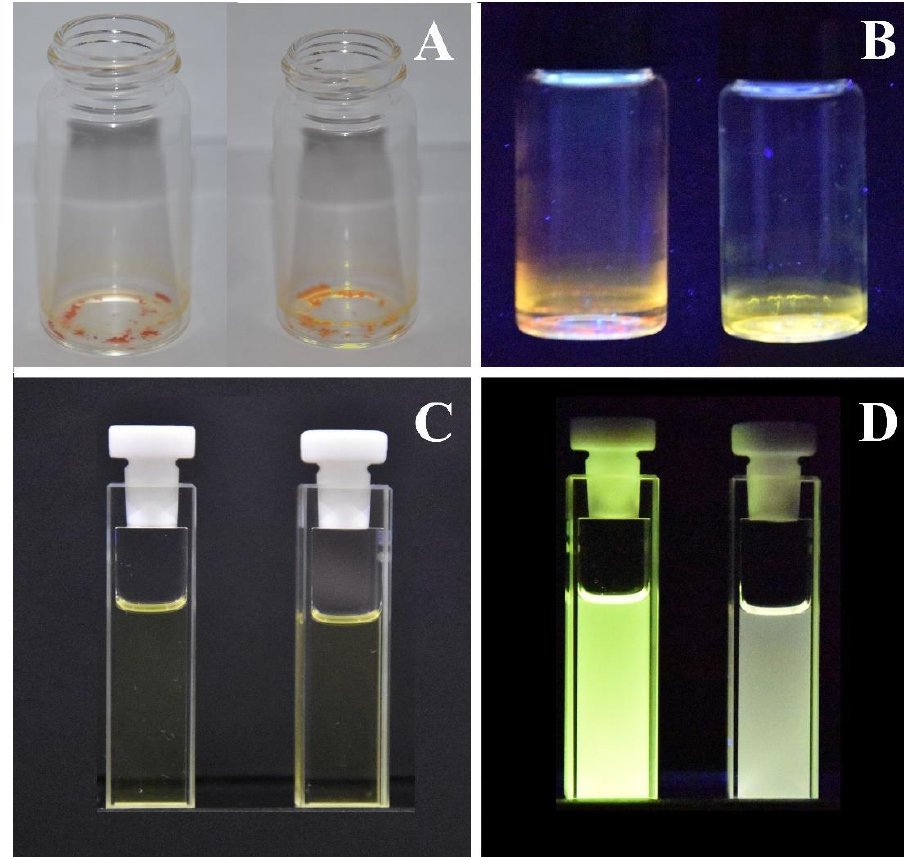
Figure 1. Crystalline samples of C1b ( A on the left) and C2b ( A on the right) in visible light and under 365 nm UV lamp light ( B ). The same samples dissolved in a dilute chloroform solution in natural ( C ) and under 365 nm UV lamp light ( D ).